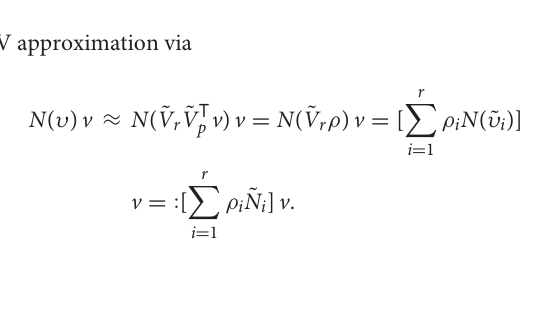
LPV approximation